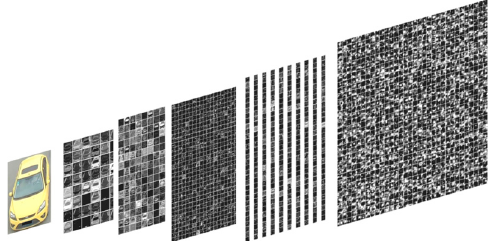
Figure 5. Five-layer feature map of vehicle extracted by ResNet-50.